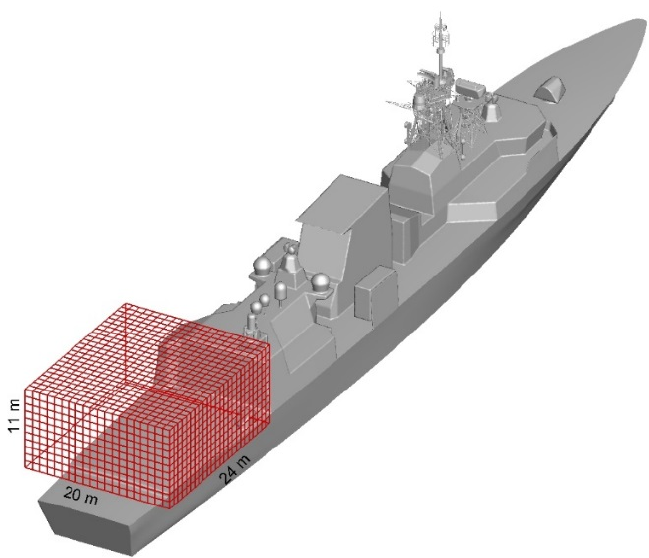
Figure 6. CPF extraction box for the flight simulator look-up tables.